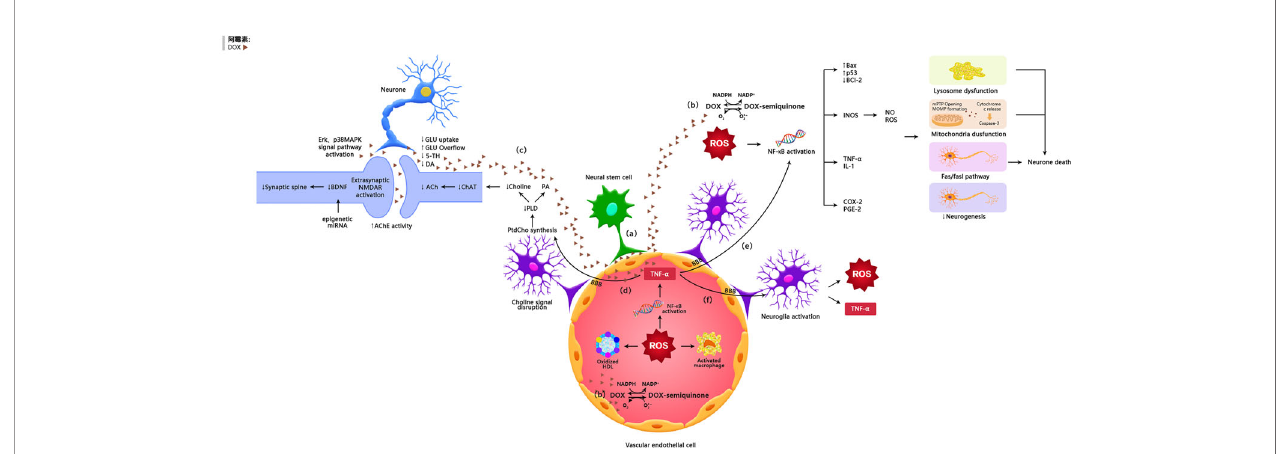
FIGURE 1 | The possible mechanisms of doxorubicin-induced chemobrain. (A) Doxorubicin can cross the blood-brain barrier through vascular-associated apical projections of neural stem cells. (B) Oxidative Stress Ptahway. (C) Synaptic dysplasia. (D) TNF- a is involoved in neurotransmitter pathways. (E) TNF- a is involved in oxidative stress pathways. (F) TNF- a ampli fi es in fl ammatory signals by activating glial